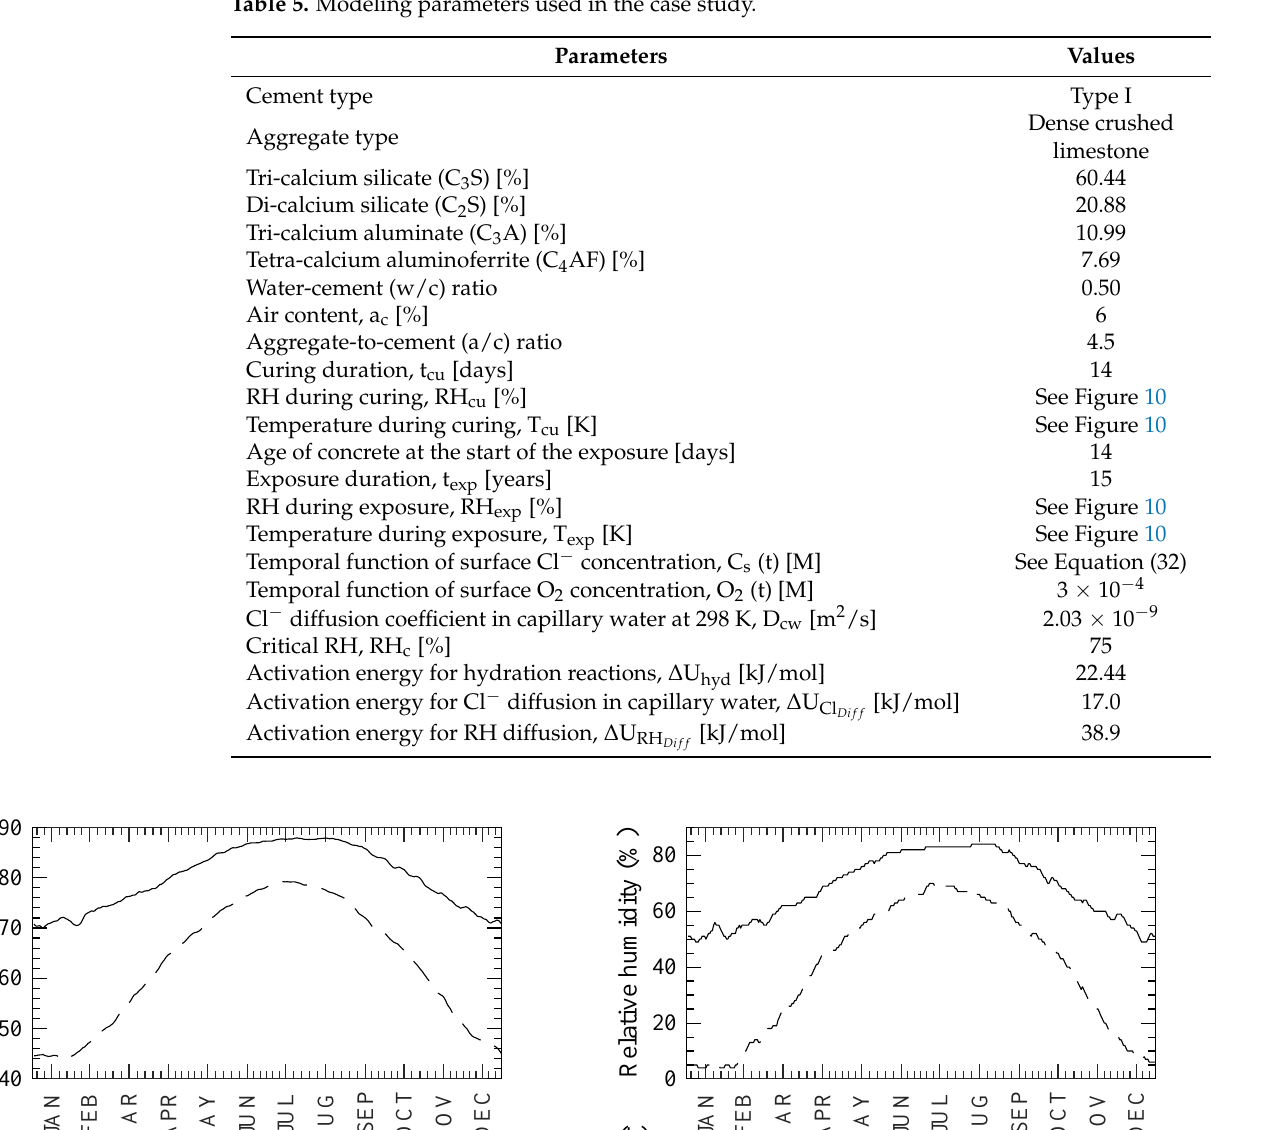
Table 5. Modeling parameters used in the case study.